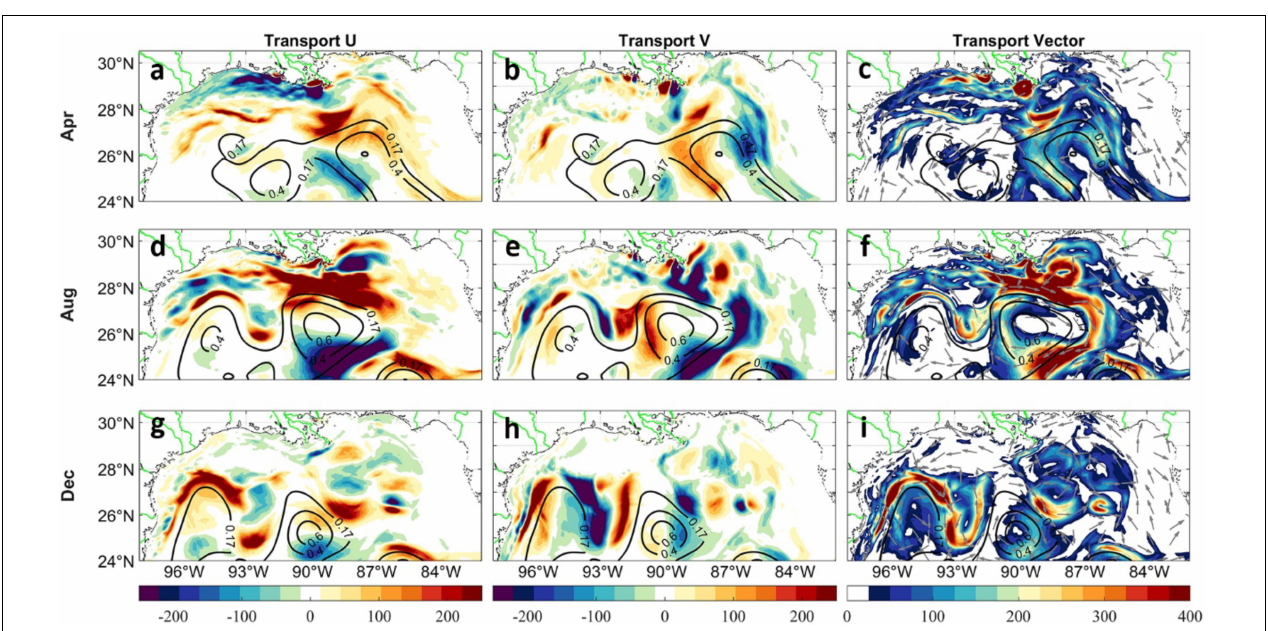
FIGURE 8 | Monthly averaged freshwater zonal (a,d,g) and meridional (b,e,h) transport, as well as the transport vector (c,f,i) integrated over the upper 100 m in April, August, and December, 2015. The fields are obtained from the first member of the SP active ensemble. Units: m 3 /s. Contours show monthly averaged